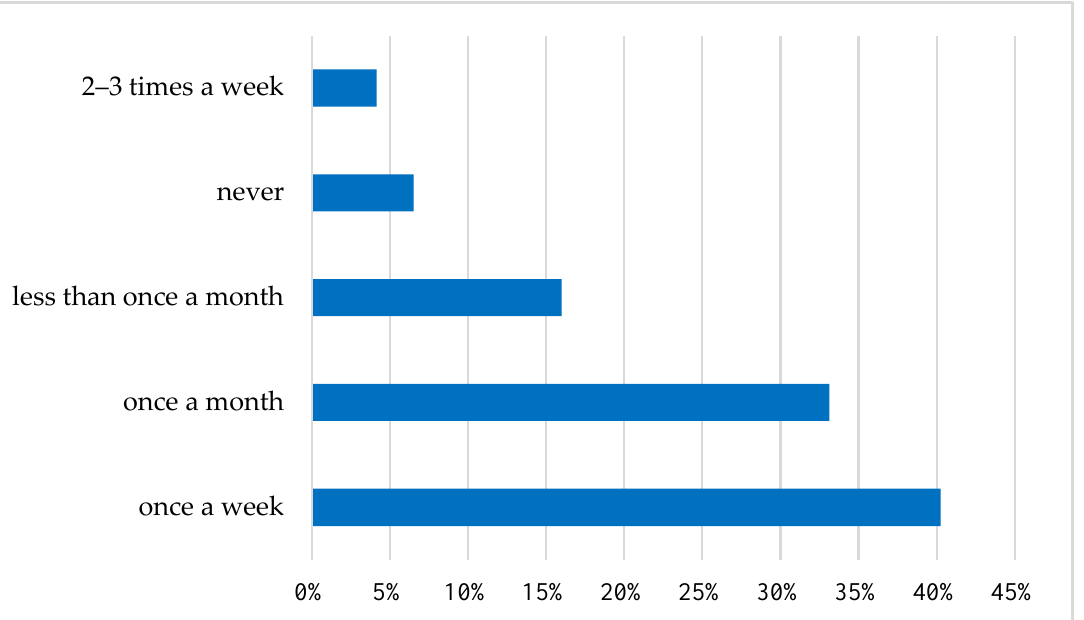
Figure 3. Frequency of fish consumption in Poland among the Young Adult Populations. Source: own elaboration based on data of [43].